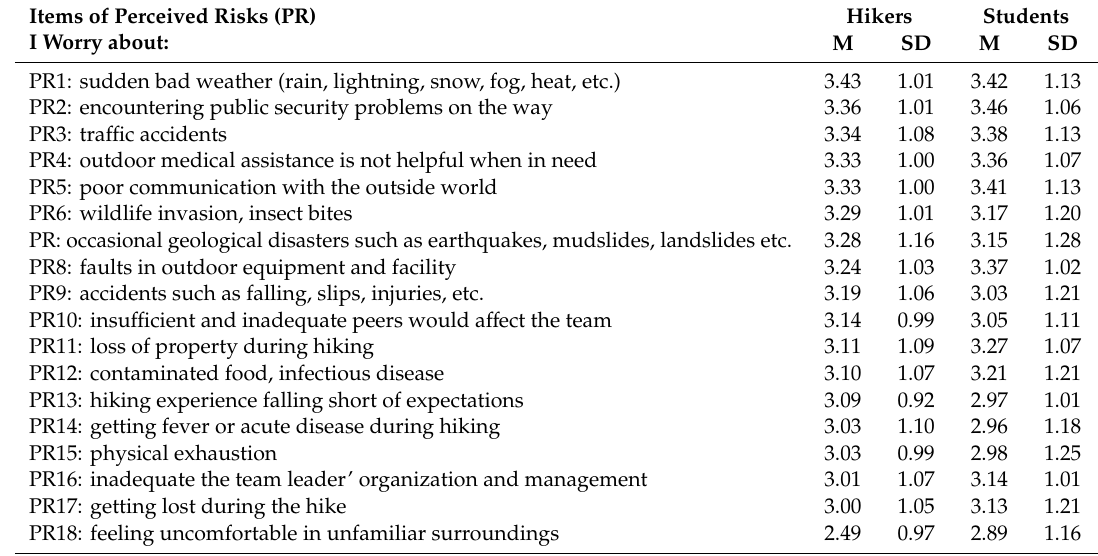
Table 3. Description of hiking risk